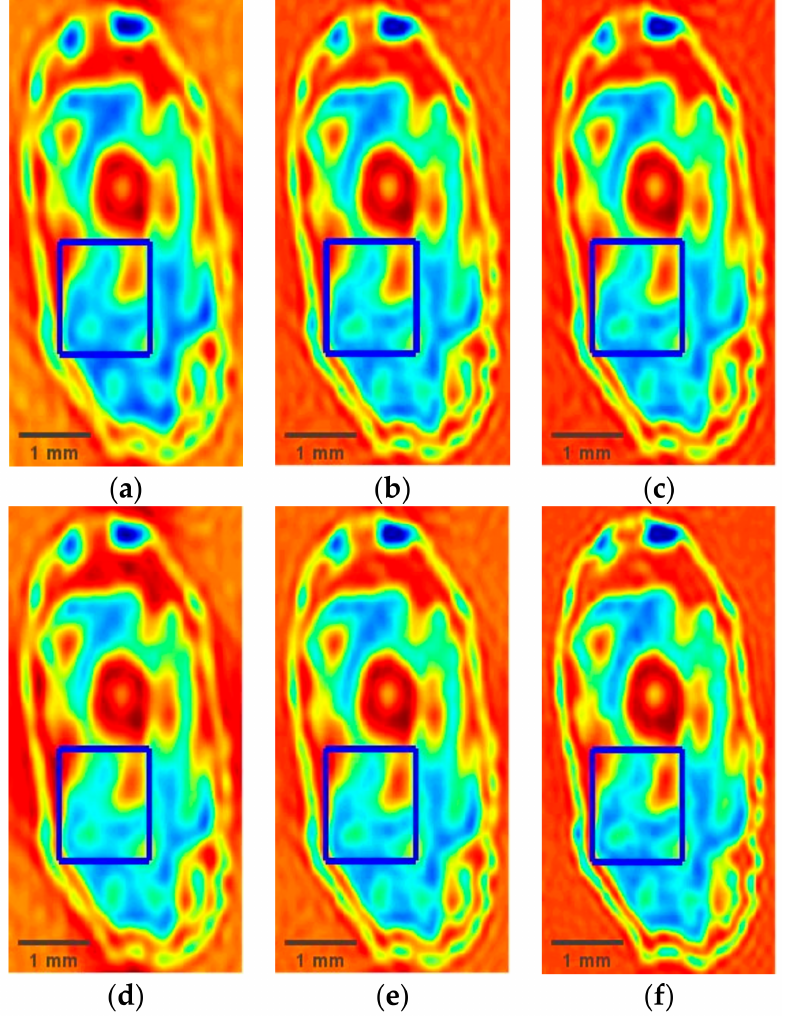
Figure 7. Reconstructed results comparation of DSC-THz and SSC-THz with different sampling rates for the wheat seed. ( a ) DSC-THz with sampling rate 20%; ( b ) DSC-THz with sampling rate 30%; ( c ) DSC-THz with sampling rate 40%; ( d ) SSC-THz with sampling rate 20%; ( e ) SSC-THz with sampling rate 30%; ( f ) SSC-THz with sampling rate